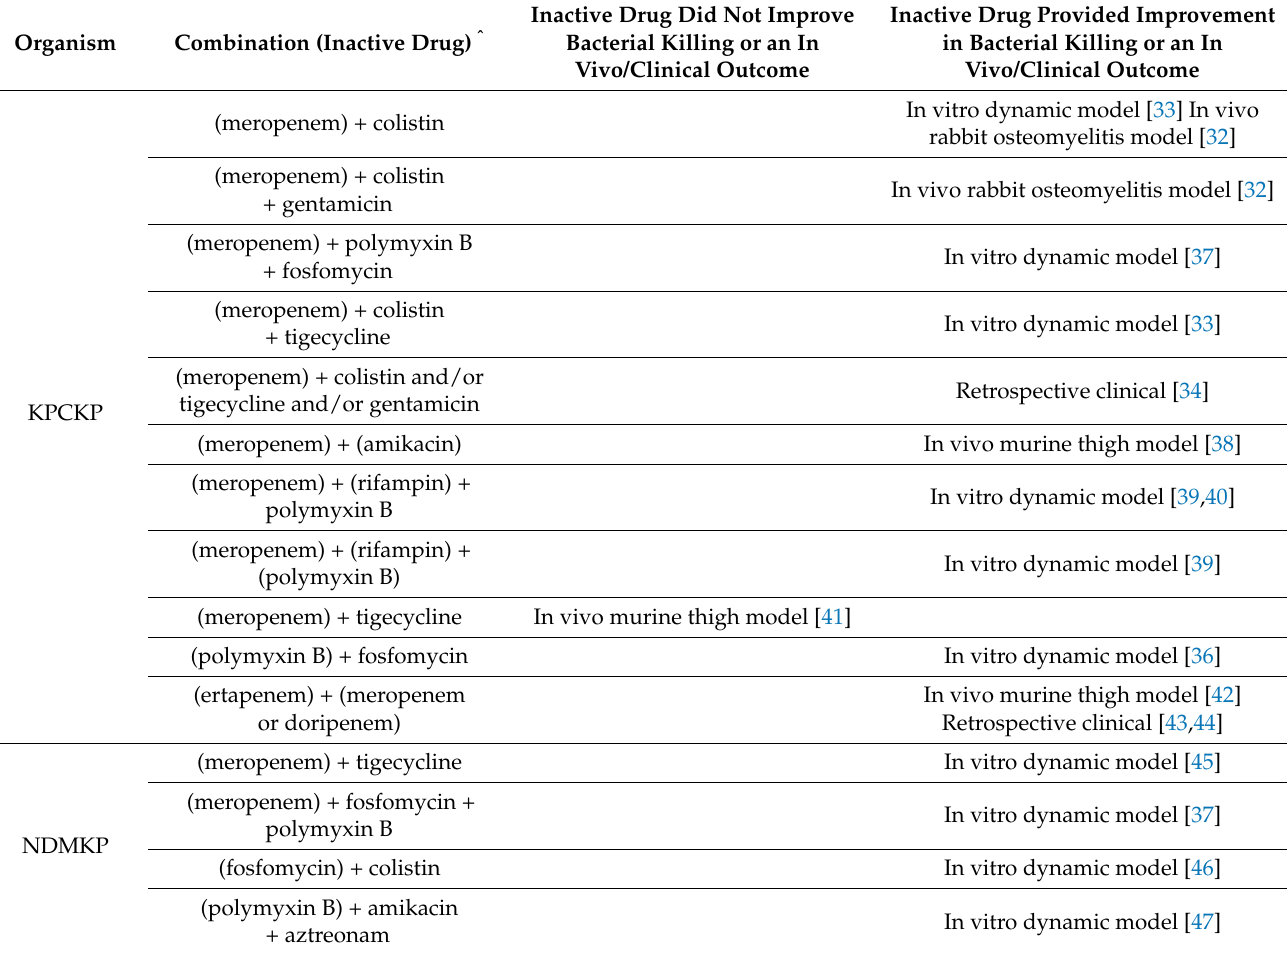
Table 2. Summary of studies that investigated antibacterial combinations against K. pneumoniae that included at least one drug that was inactive individually. Studies are reported in the table if the combination was investigated using a dynamic in vitro model, an in vivo model, or the investigation was completed in the clinic. Susceptibility studies, checkerboard analyses, and static time-killing experiments are not reported in the table due to the preliminary nature of the experiments and the extensive combinatorial permutations that are difficult to summarize